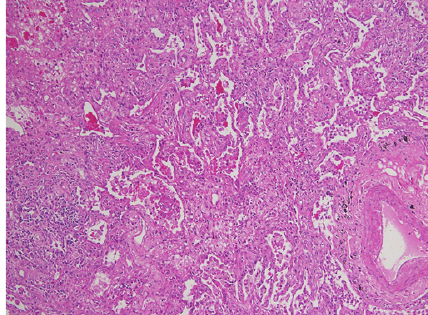
Figure 2: Lung biopsy shows inflammatory debris and foamy histiocytes within small airways, alveolar ducts, and adjacent alveoli (hematoxylin-eosin stain, ×